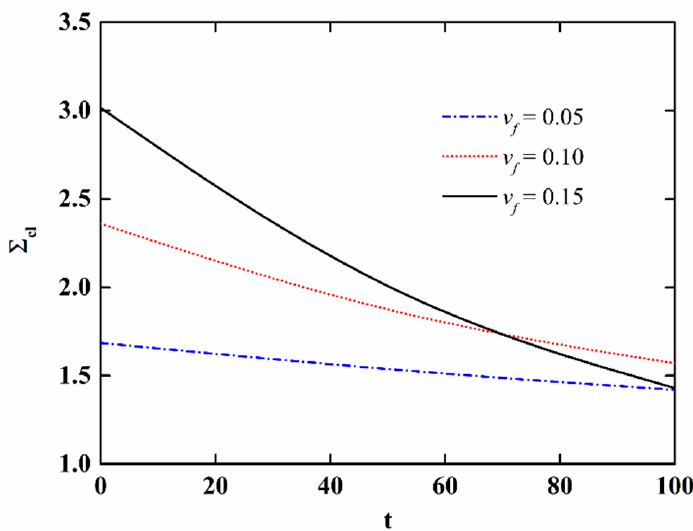
Figure 9. Variation in the critical load of imperfect NFRC cylindrical shells with aging time.